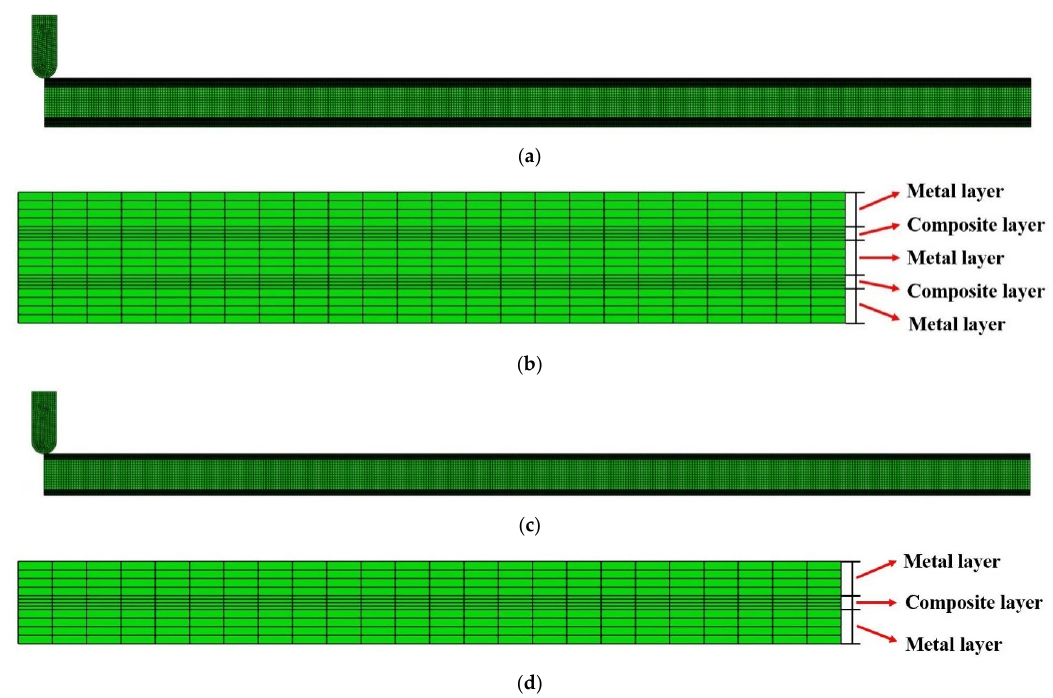
Figure 3. FE models of the two cases: ( a ) Half of the FML sandwich beam loaded by the roller (Case 1); ( b ) details of the FML face sheet (Case 1); ( c ) half of the FML sandwich beam loaded by the roller (Case 2); ( d ) details of the FML face sheet (Case 2).